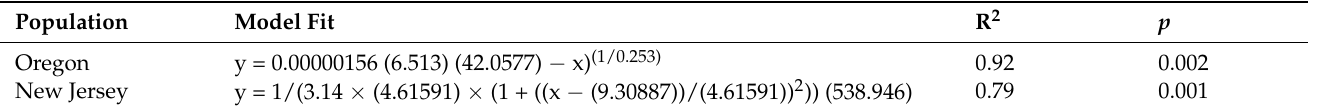
Table 2. Model fit of oviposition in two population (Oregon and New Jersey, USA).